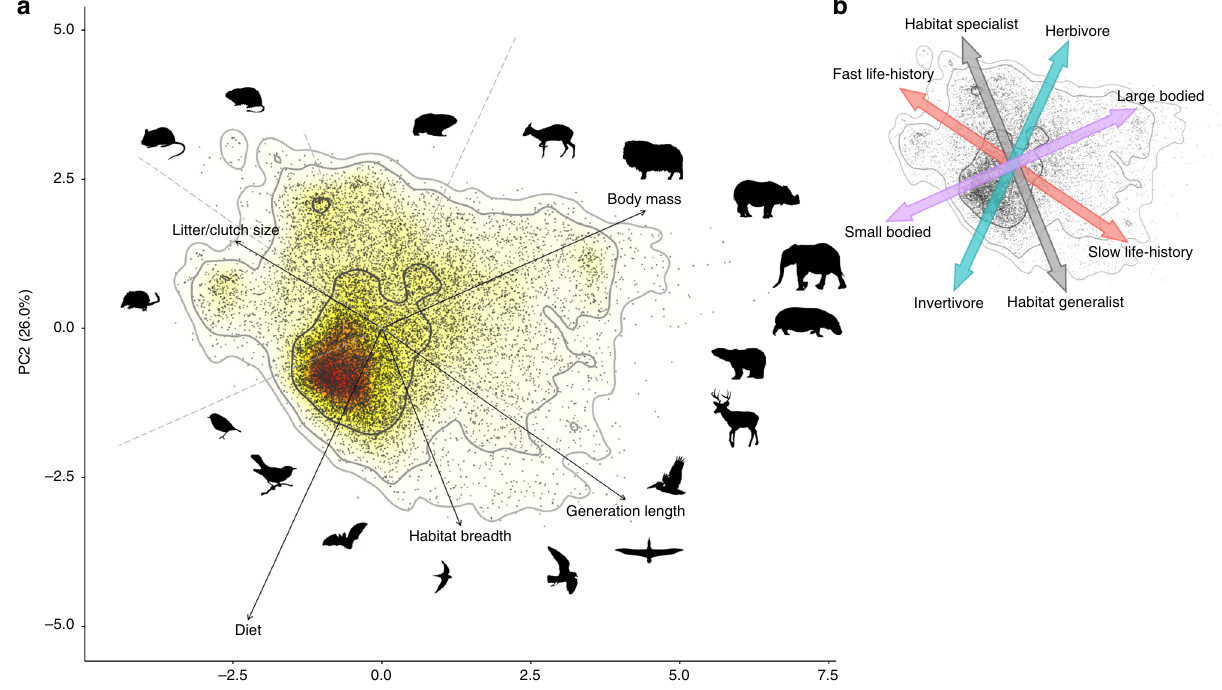
Fig. 1 The ecological strategy surface for mammals and birds. a Projection of 15,484 living land mammal and bird species (dots) on the surface de fi ned by principal component axes (PC) 1 and 2 (mean values across 25 imputed datasets; Supplementary Methods; Supplementary Fig. 2). Solid arrows indicate direction and weighting of vectors representing the fi ve continuous traits analyzed (Supplementary Table 1 for loadings). Silhouettes show a selection of species characterizing the edges of strategy space (eight silhouettes were freely downloaded from PhyloPic www.phylopic.org, under CC0 1.0 Public Domain Dedication, while the rest were created in Inkscape by the authors; Supplementary Fig. 3 for species locations, scienti fi c names and image sources). The color gradient indicates regions of highest (red) to lowest (white) occurrence probability of species across the ecological strategy surface, with contour lines indicating 0.5, 0.95, and 0.99 quantiles. Percentage values represent proportion of the total variation explained by each PC. To quantify diet, we extracted the dominant diet gradient across ten diet categories for all species, using a principal coordinates analysis (PCoA; Supplementary Fig. 4). b The ecological strategy surface is also illustrated with simpli fi ed gradients. Source data are provided as a Source Data fi